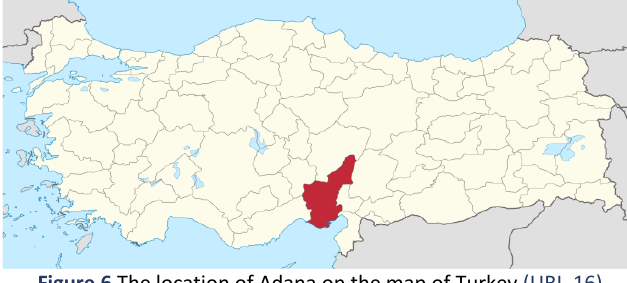
Figure 6 The location of Adana on the map of Turkey